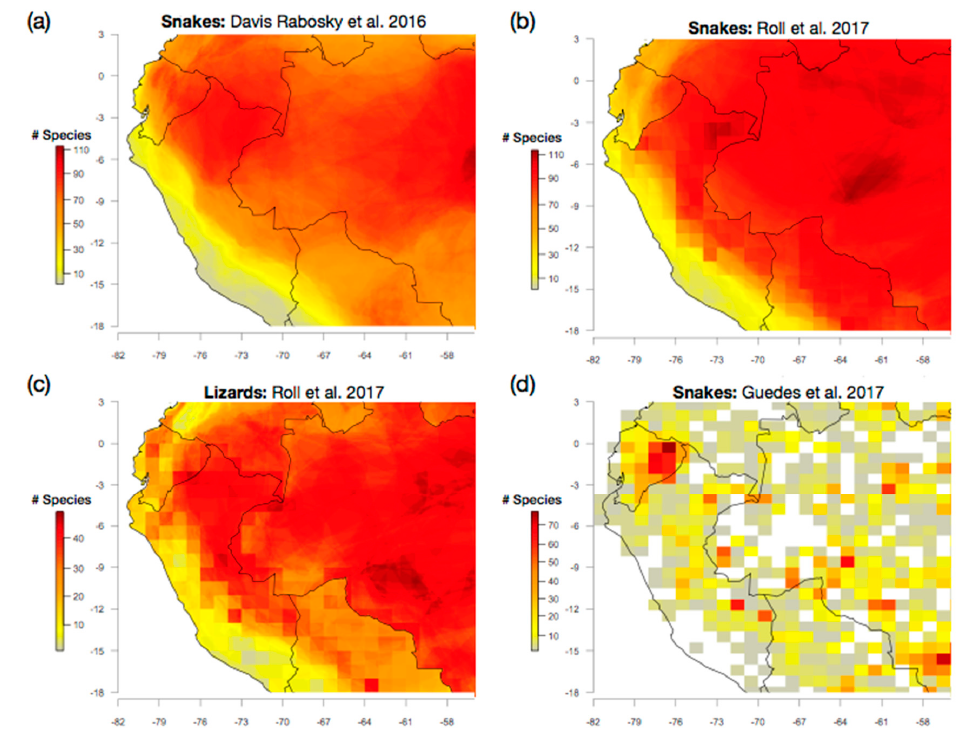
Figure 1. Species richness for squamate reptiles in the western Amazon basin as inferred from range reconstructions and primary occurrence data. Estimates of snake ( a , b ) and lizard ( c ) species richness from published range maps [13,14] suggests higher diversity in the western equatorial Amazon (northern Peru, Ecuador) relative to southern Peru. ( d ) Snake species richness from georeferenced museum occurrence data [12] is consistent with higher richness in the Ecuadorian Amazon relative to southern Peru. Results in ( d ) are heavily a ff ected by biases in sampling and data availability; the data compilation included proportionately fewer occurrence records maintained by Peruvian